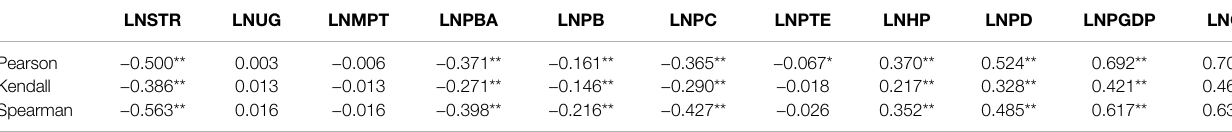
TABLE 2 | Correlation analysis and test of indicators.